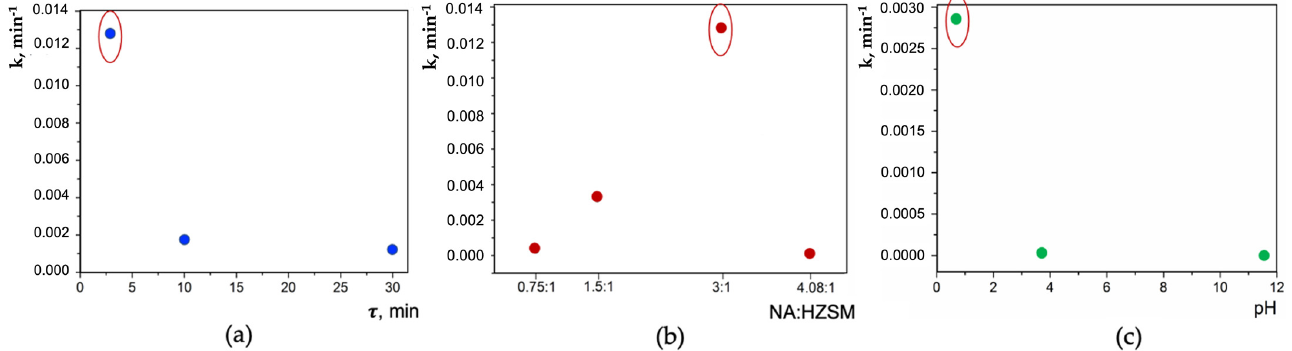
Figure 10. Relationship between the photoreaction rate constant (k, min − 1 ) and synthesis duration ( τ ) ( a ), NA:HZSM(12) ratio ( b ), pH of the precursor TiOSO 4 ×xH 2 SO 4 ×yH 2 O ( c ) for NA/HZSM(12) (initial NA/HZSM(12) is marked with oval) (data from [54]).